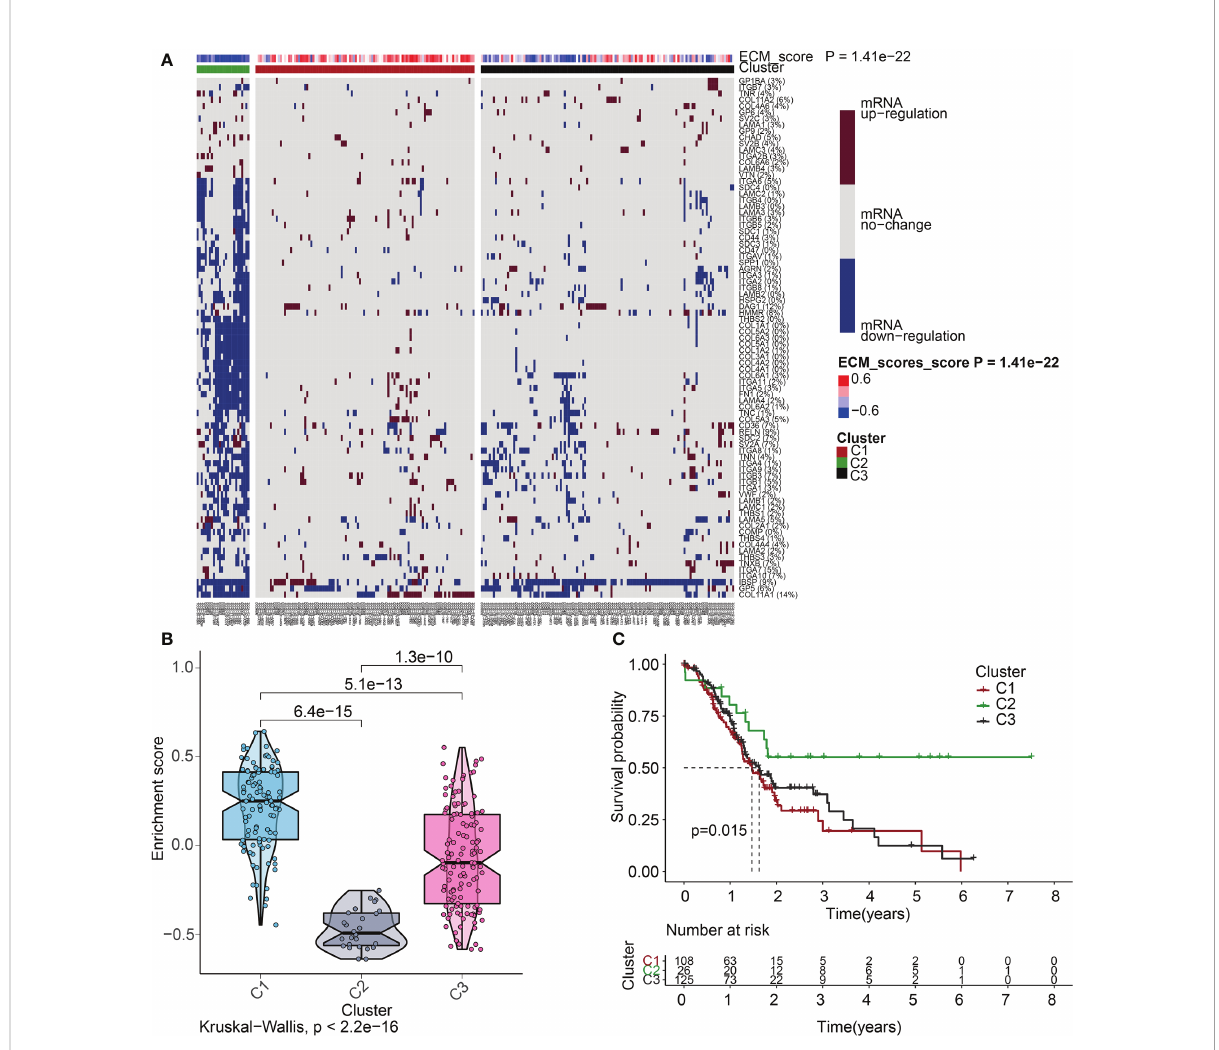
FIGURE 5 ECM score-based clustering analysis. (A) Clustering of gene data illustrates 3 clusters displayed by the heat map: ECM active [cluster 1 (C1)], ECM inactive [cluster 2 (C2)], and normal ECM [cluster 3 (C3)]. The proportion of patients with upmodulated genes is shown on the right side of the fi gure. In the color bar on the right side, red denotes mRNA up-modulation, blue signi fi es mRNA downmodulation, and white denotes mRNA no-regulation. The ECM score is displayed in four different colors, with negative values shown in blue and positive ones shown in red. (B) The “ ggpubr ” package ’ s violin plot indicates that the enrichment scores of the three clusters, from high to low, are C2, C3, and C1. The “ kruskal.test ” was employed in this study, and the p-values are presented above the clusters. (C) A survival curve depicting the three different clusters. Cluster 2 has a better survival rate compared to either cluster 1 or cluster 3. Cluster 1 is denoted by the red line, cluster 2 is denoted by the green line, and cluster 3 is denoted by the black line. The number of years is signi fi ed by the abscissa, while the rate of survival is denoted by the